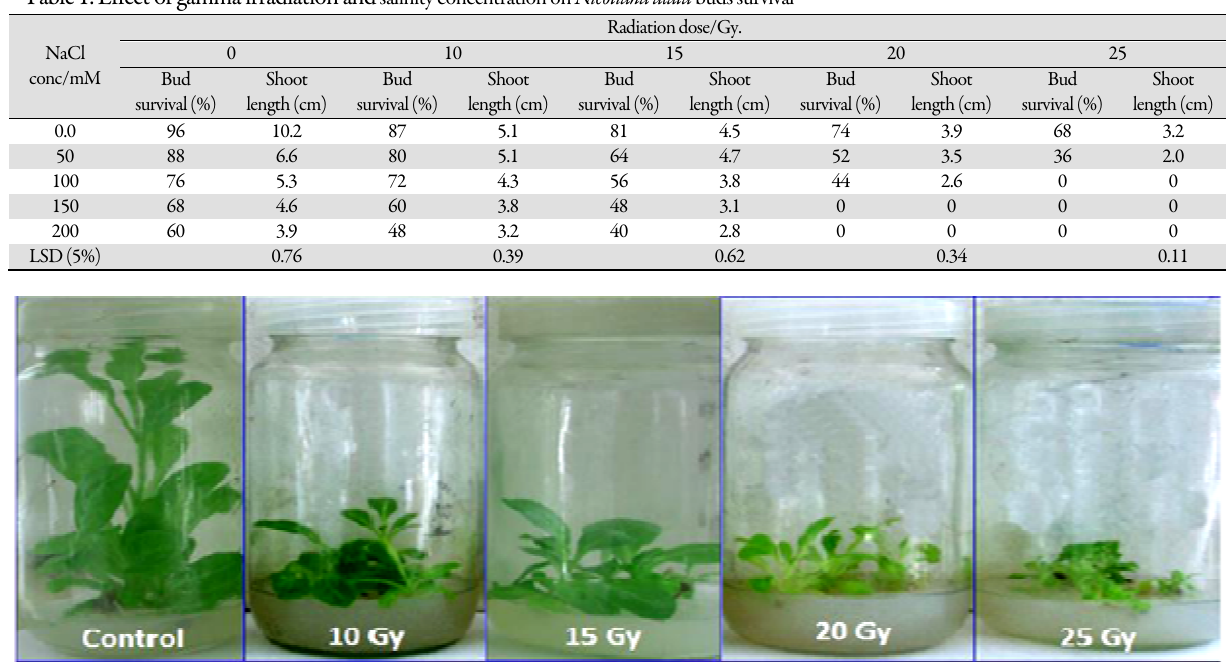
Table 1. Effect of gamma irradiation and salinity concentration on Nicotiana alata buds survival NaCl conc/mM 0.0